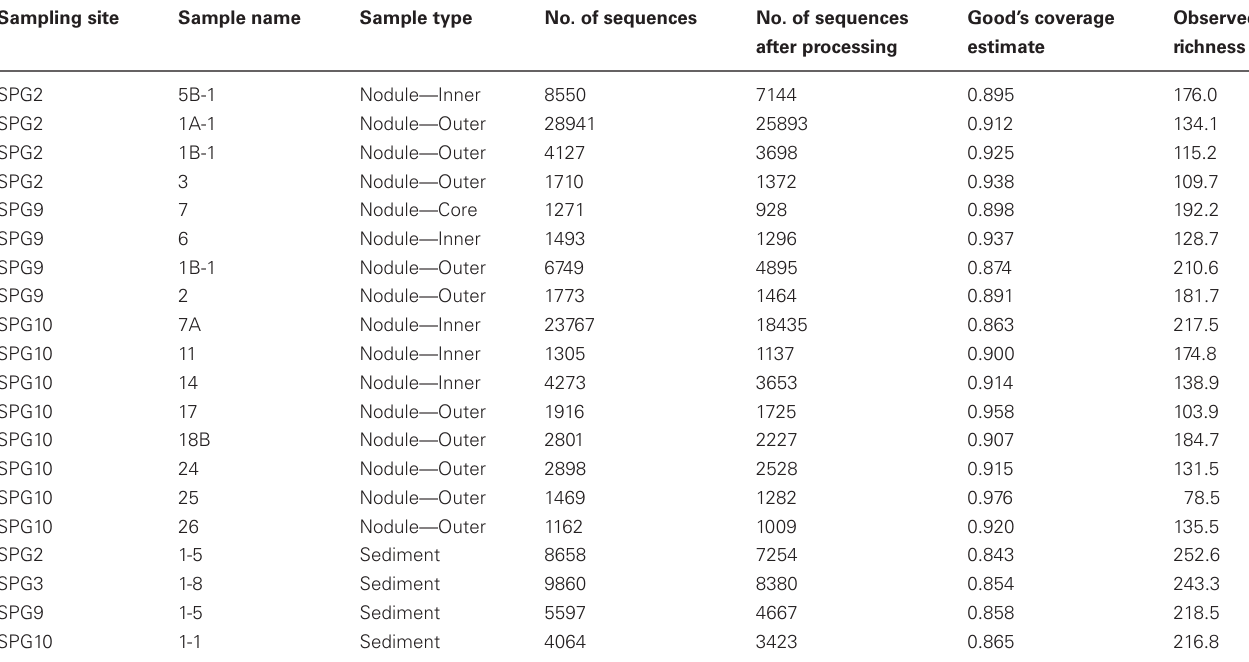
Table 2 | Sequence effort and diversity measures for each